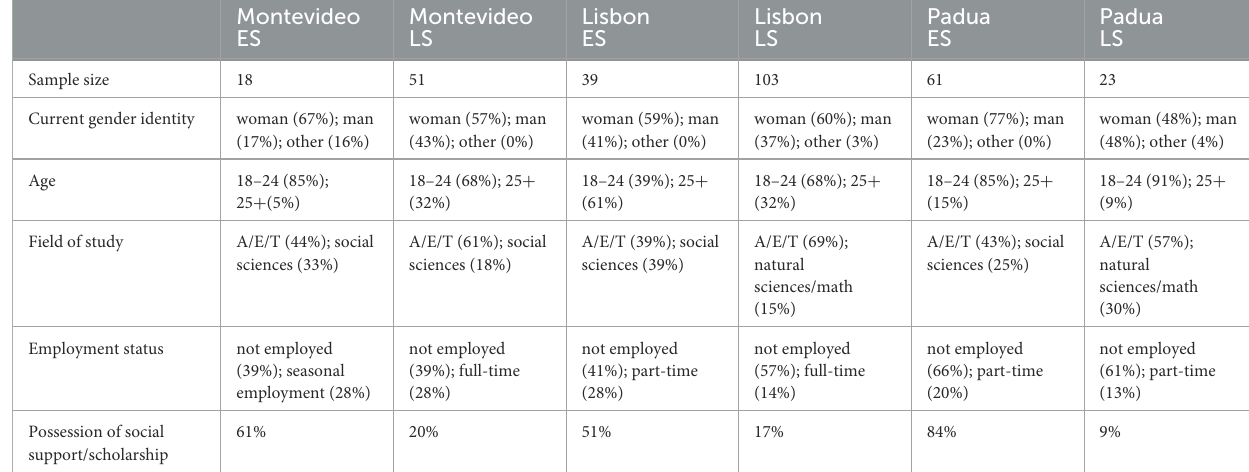
TABLE 2 Characterization of the survey sample: sample size, and general description of respondents (current gender identity, age, field of study (2 most common), employment status (2 most common), and possession of social support/scholarship (A/E/T,